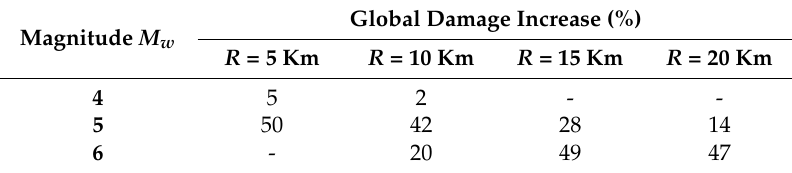
Table 5. The global damage increases when considering the local site effects.